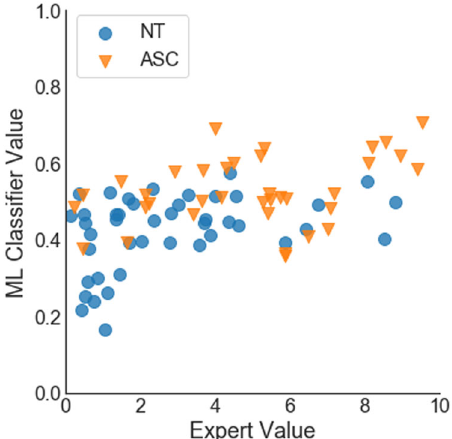
Fig. 2 Class probability for ASD and participant ’ s ADOS score.